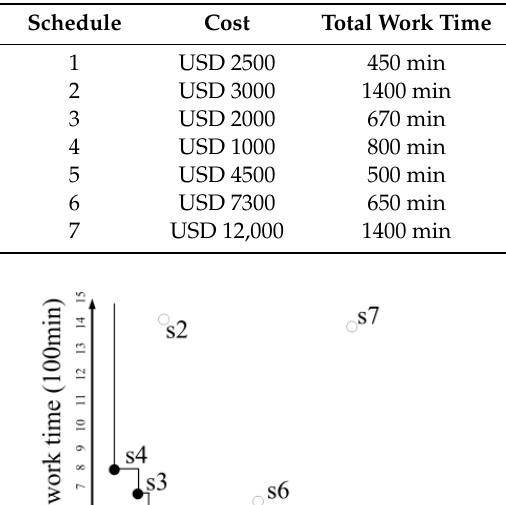
Table 1. The example of skyline schedules.